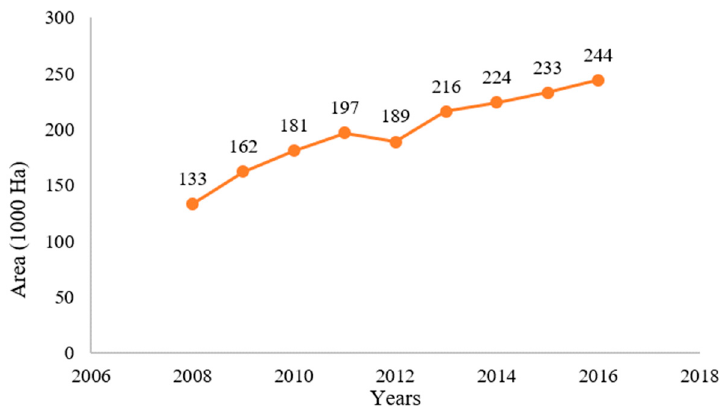
Figure 1. Increase in the area of swampy wetlands used for rice production in Ghana (Reproduced from [24], with permission from ICT and Data Management Services, 2020).